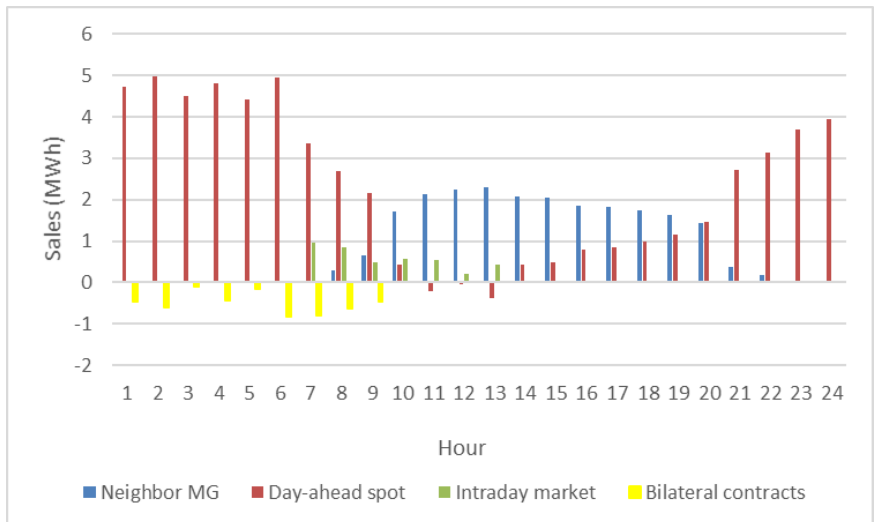
Figure 9. Negotiation scheduling for MGCC 2.